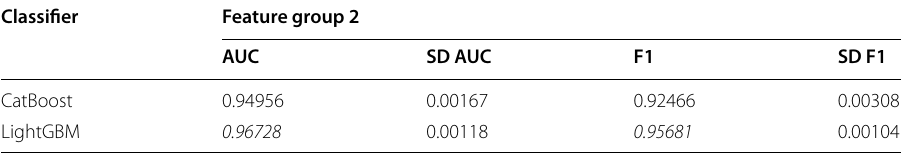
Best metrics are highlighted in italics; SD AUC is the standard deviation of AUC and SD F1 is the standard deviation of the F1-score Table 22 Mean performance of CatBoost and LightGBM in terms of AUC and F1-score on datasets with features from feature group 3